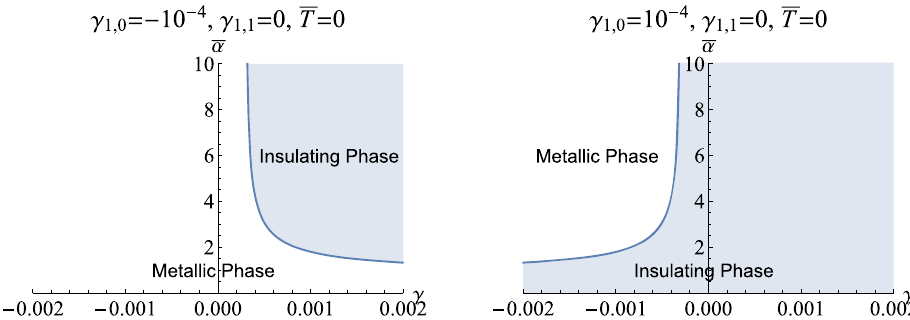
Fig. 6 Phase diagram over (γ, ¯ α) plane for the MIT from four derivative theory at zero temperature (left plot for γ 1 , 0 = − 10 − 4 and right plot for γ